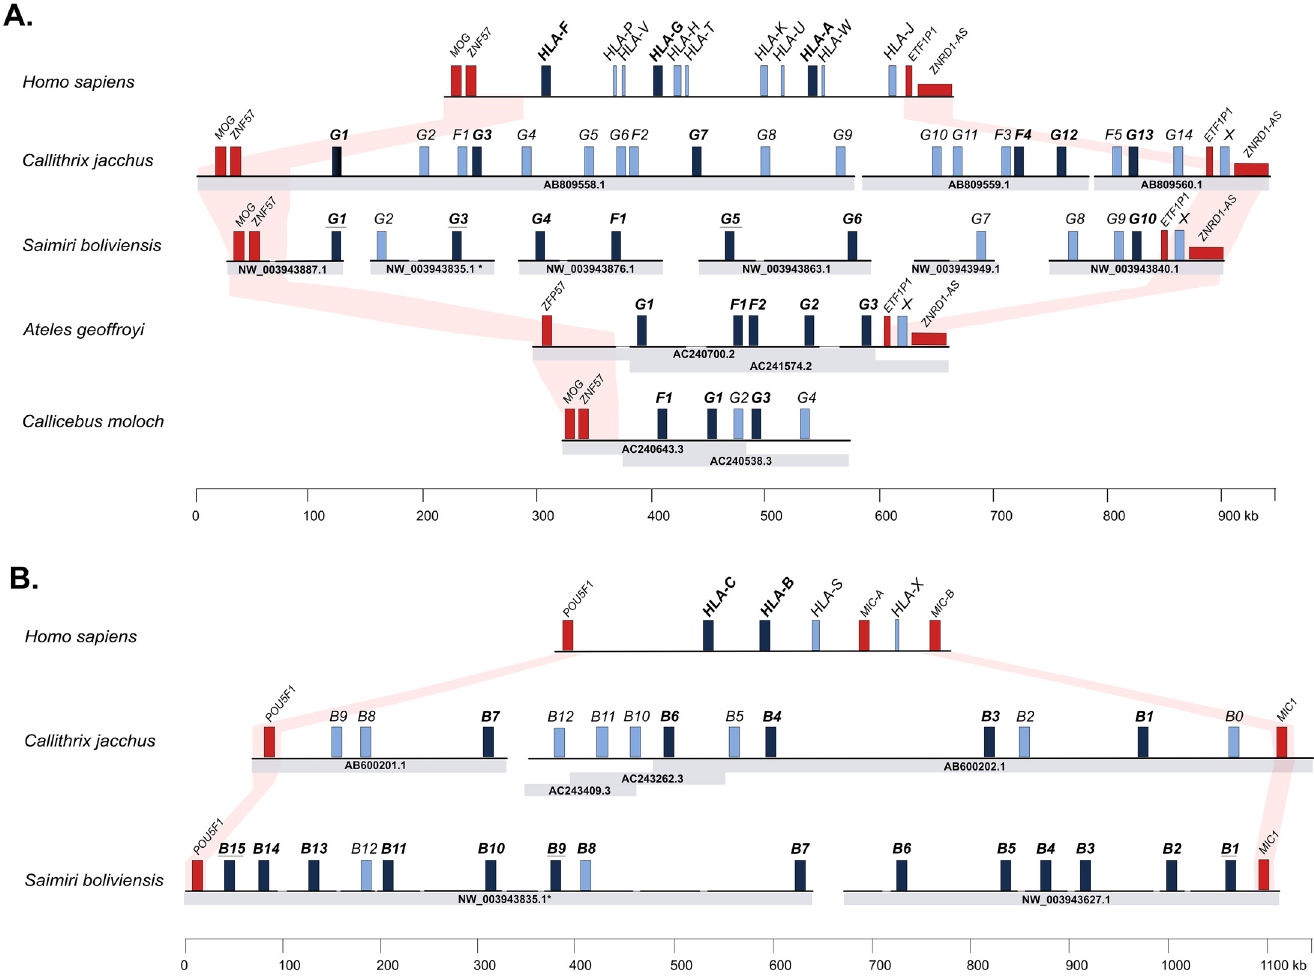
Fig 1. Comparison of the MHC class I region of S . boliviensis , A . geoffroyi , and C . moloch using as reference that of humans [3] and C . jacchus [15, 16]. A, MHC class I alpha block ( MHC-A/G/F ). B, MHC class I beta block ( MHC-B/C ). Red rectangles represent centromeric and telomeric framework genes, dark blue rectangles indicate putatively transcribed MHC class I genes, including partially sequenced genes (names underlined), and light blue rectangles depict MHC class I pseudogenes. BAC clone or scaffold accession numbers are indicated for each species. The S . boliviensis scaffold NW_003943835.1 contained MHC-G-like and MHC-B sequences, likely reflecting an erroneous assembly, but for clarity, the genes were located in their respective regions. Non-MHC class I sequences annotated in these regions are shown in S1 Table.